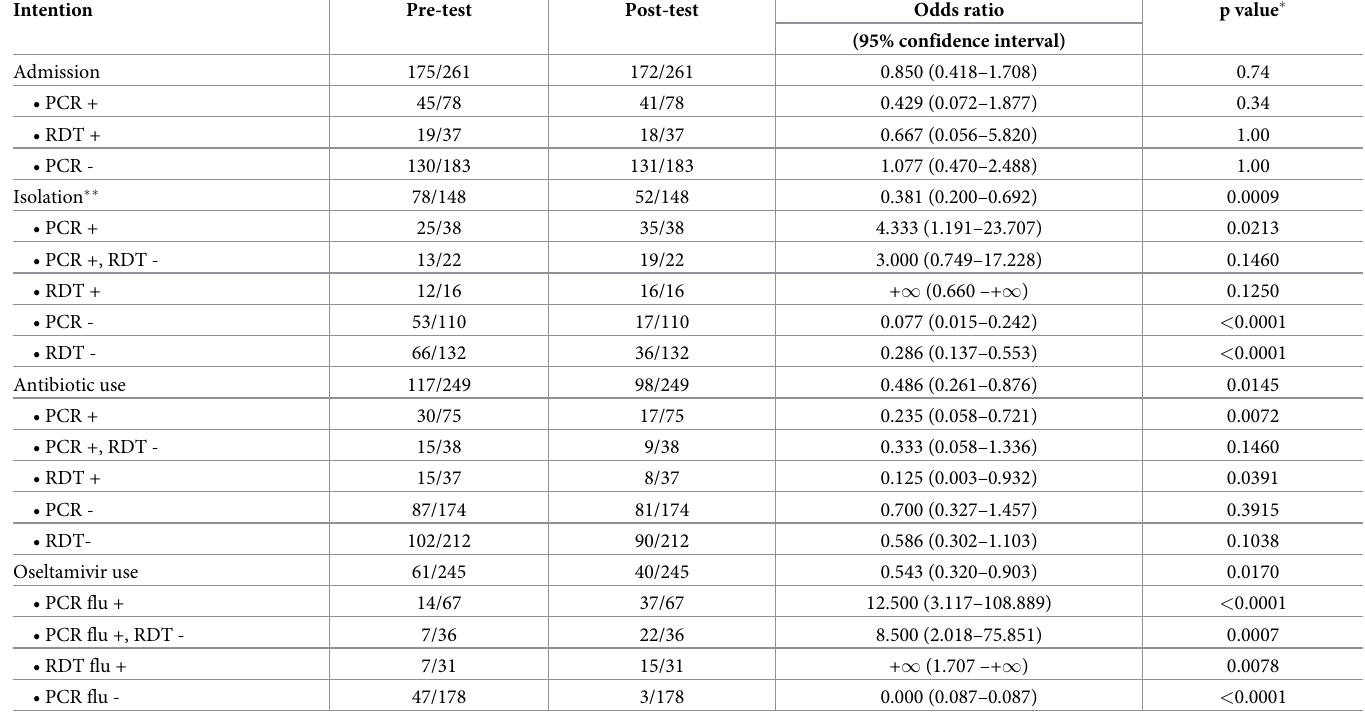
Table 3. Clinical impact of the positive (+) and negative (-) results of the PCR and antigen rapid diagnostic test (RDT) for respiratory syncytial virus (RSV) and influenza A and B viruses